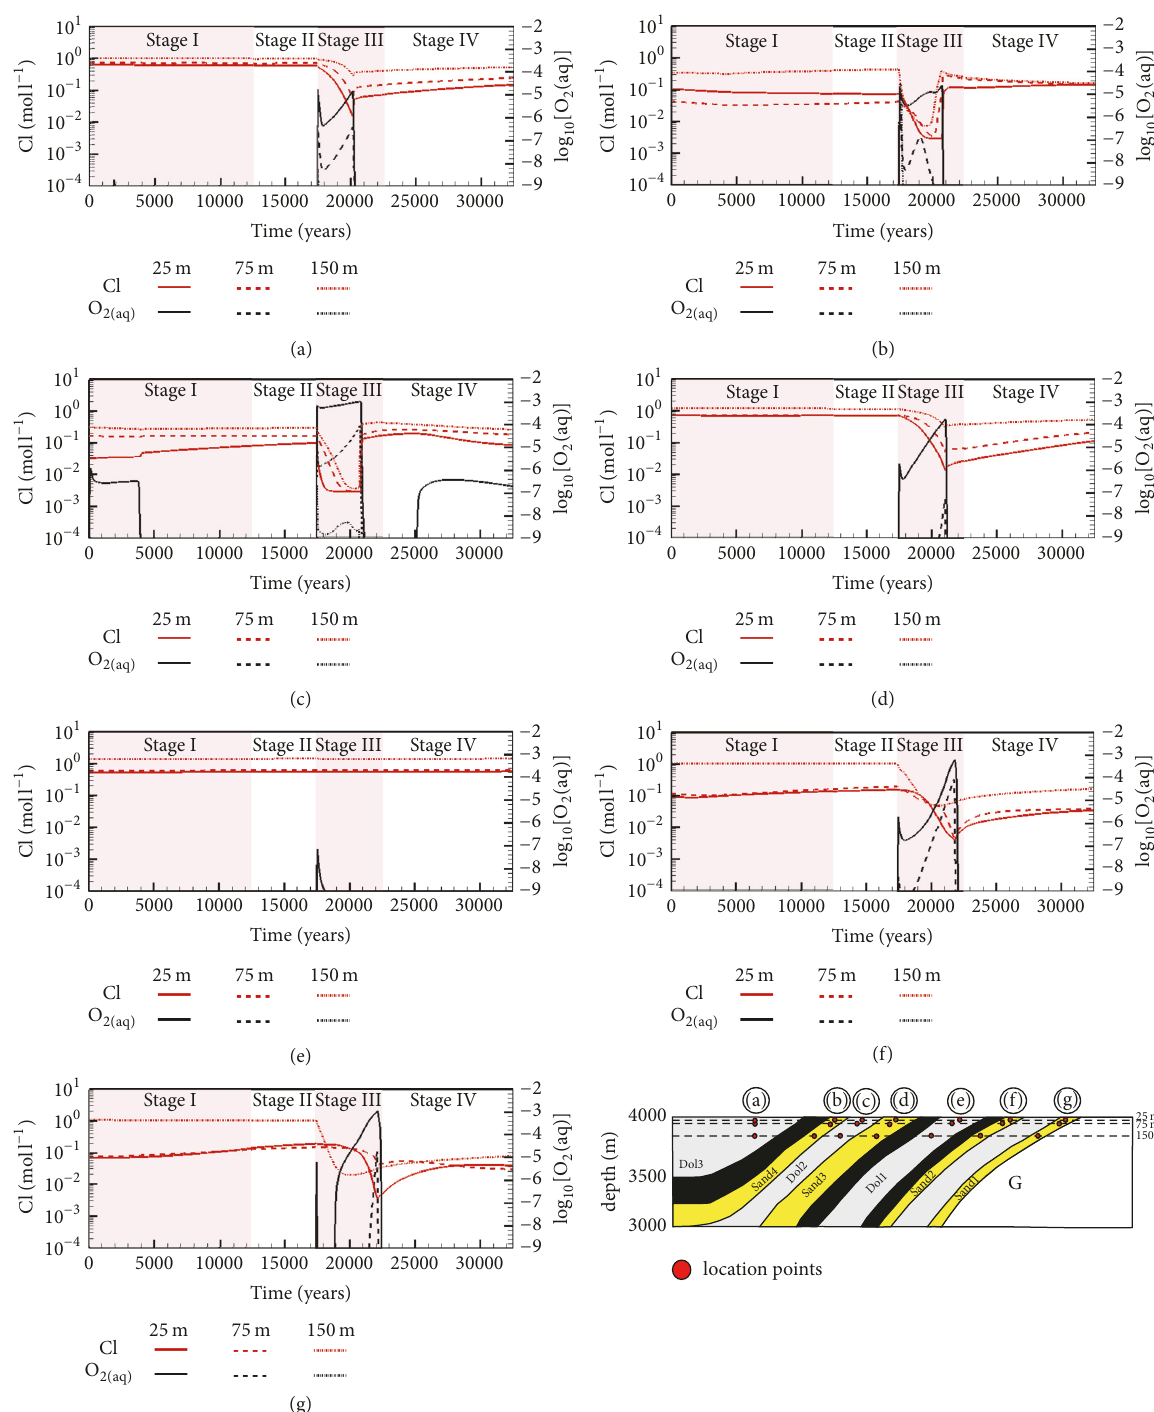
Figure 7: Temporal evolution of dissolved O 2 and Cl concentrations at the different observation point locations for the base case simulation. (a), (b), (c), (d), (e), (f), and (g) for Dol3, Sand4, Dol2, Sand3, Dol1, Sand2, and Sand1, respectively. O 2 concentrations in mol l −1 . If O 2 profiles are not visible for a specific depth and unit, concentrations remain below 1 × 10 −9 moll −1 for duration of